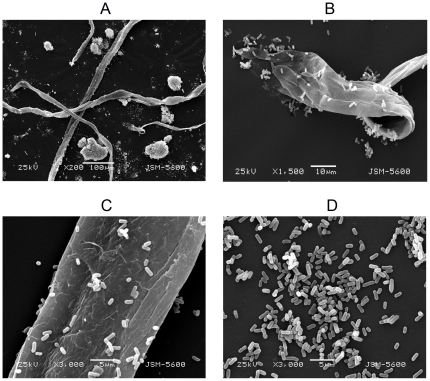
Electron micrographs of K. pneumoniae strains.A, B, and C show K7, and D shows K7R1. B and C are higher magnification views of A. C and D are at the same magnification. The images show that K7 adsorbed to the thick jelly and formed large bacterial aggregates.